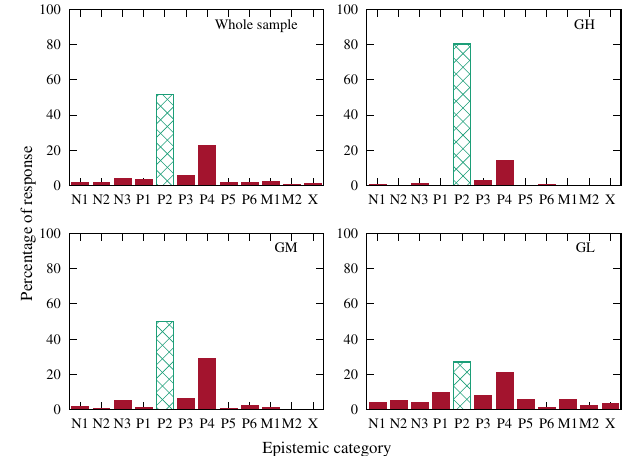
FIG. 6. Aggregate distribution of responses to all propositions (S15, S18, S22, S27) corresponding to epistemic category P1. Format of the figure is the same as in Fig. 4.